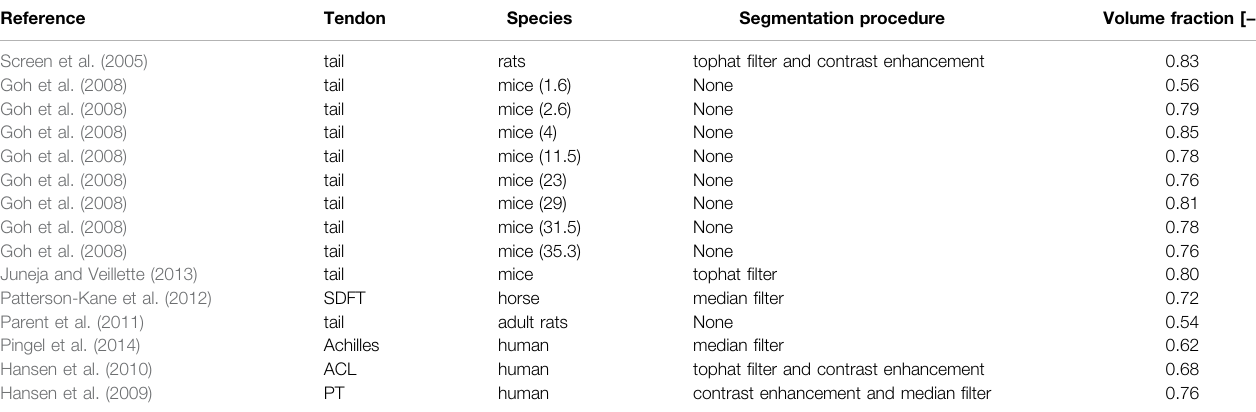
TABLE 1 | Volume fractions ofcollagen bundles within a fascicle-related RVE, determined from transmission electron micrographs (TEM) of transversecross sections taken across different species and anatomical locations. Reference Tendon